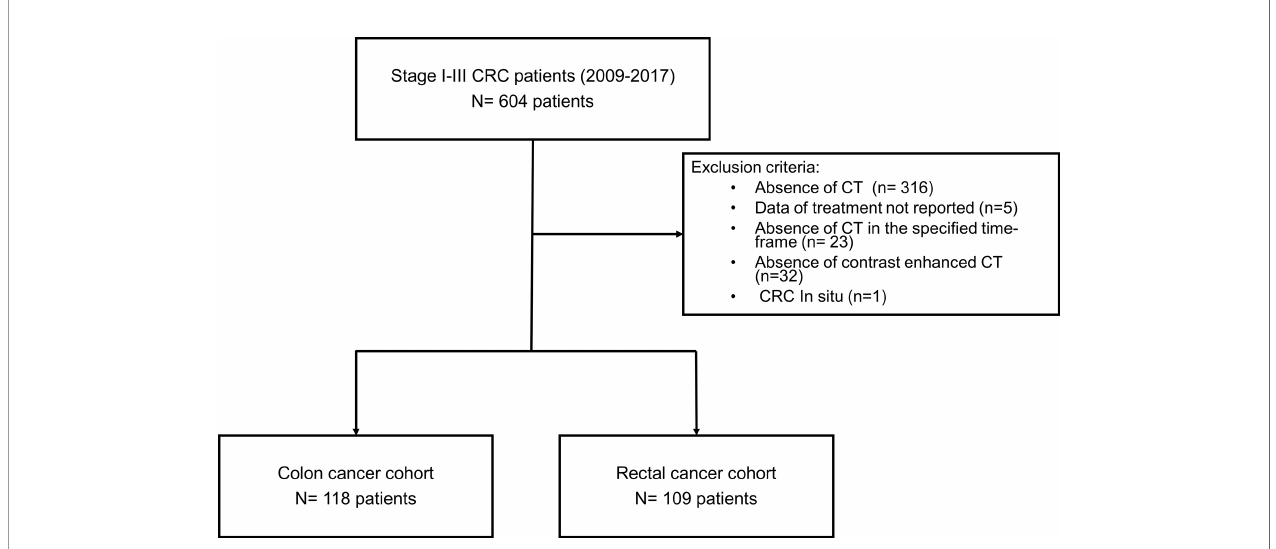
FIGURE 1 | Flow chart showing the inclusion and exclusion process for patients treated for CRC stage